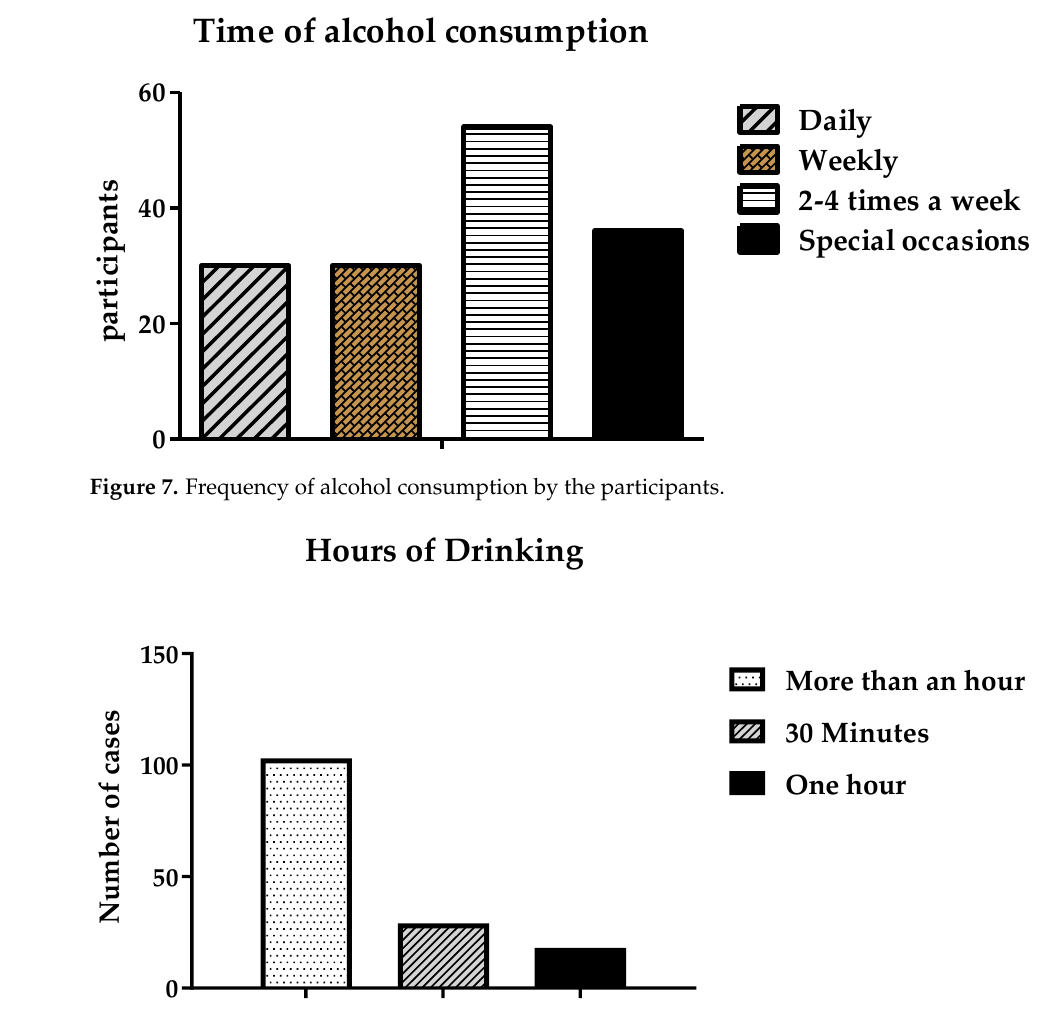
Figure 8. Time spent consuming alcohol.